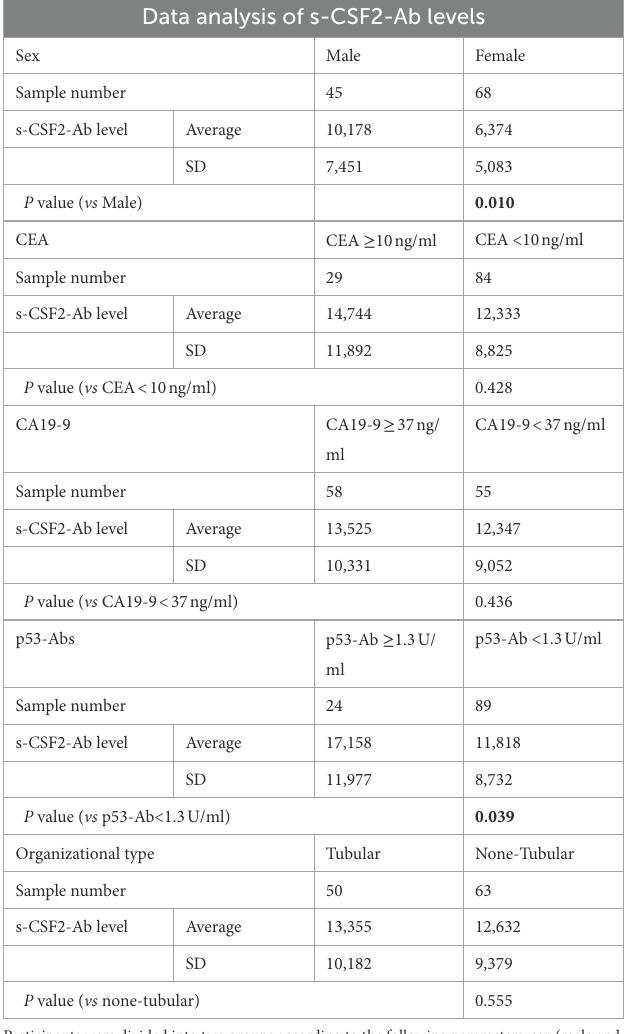
TABLE 8 Association between s-CSF2-Ab levels and data from participants in the Toho University Hospital cohort. Data analysis of s-CSF2-Ab